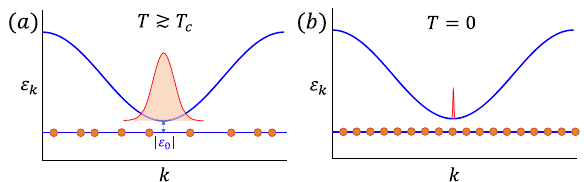
Fig. 2 Schematic illustration of the dispersion and momentum distribution function of the bosons in the model with unbounded ρ ≳ T fl at band is approximately half T c / s (0) [Eq. (12)]. a At T c , the − 1/2 bosonic particles per site occupy fi lled, and the remaining n b the dispersive band. b At T = 0, the fl at band is completely fi lled with one boson per site, and hence the super fl uid density is proportional to n b −